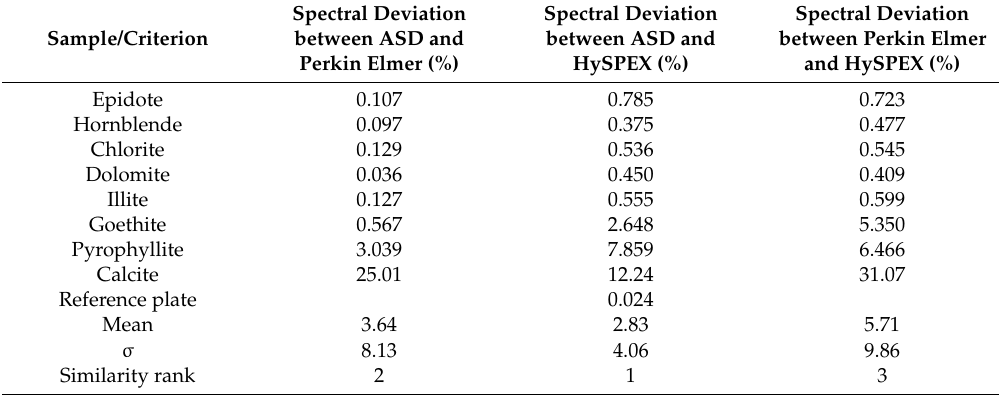
Table 5. Subjective evaluation of the spectral performance for the full spectrum.